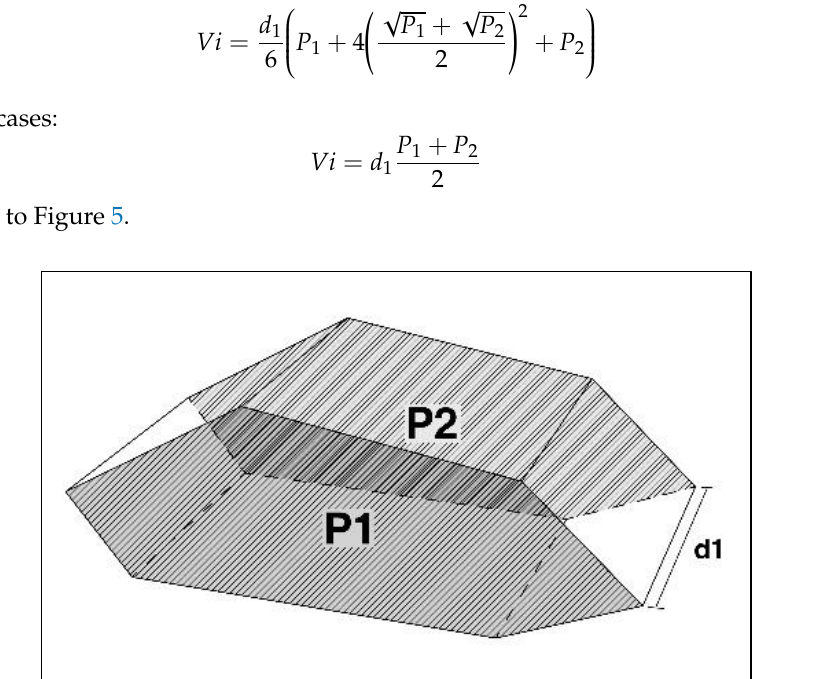
Figure 5. Cross sections for computing the volume.